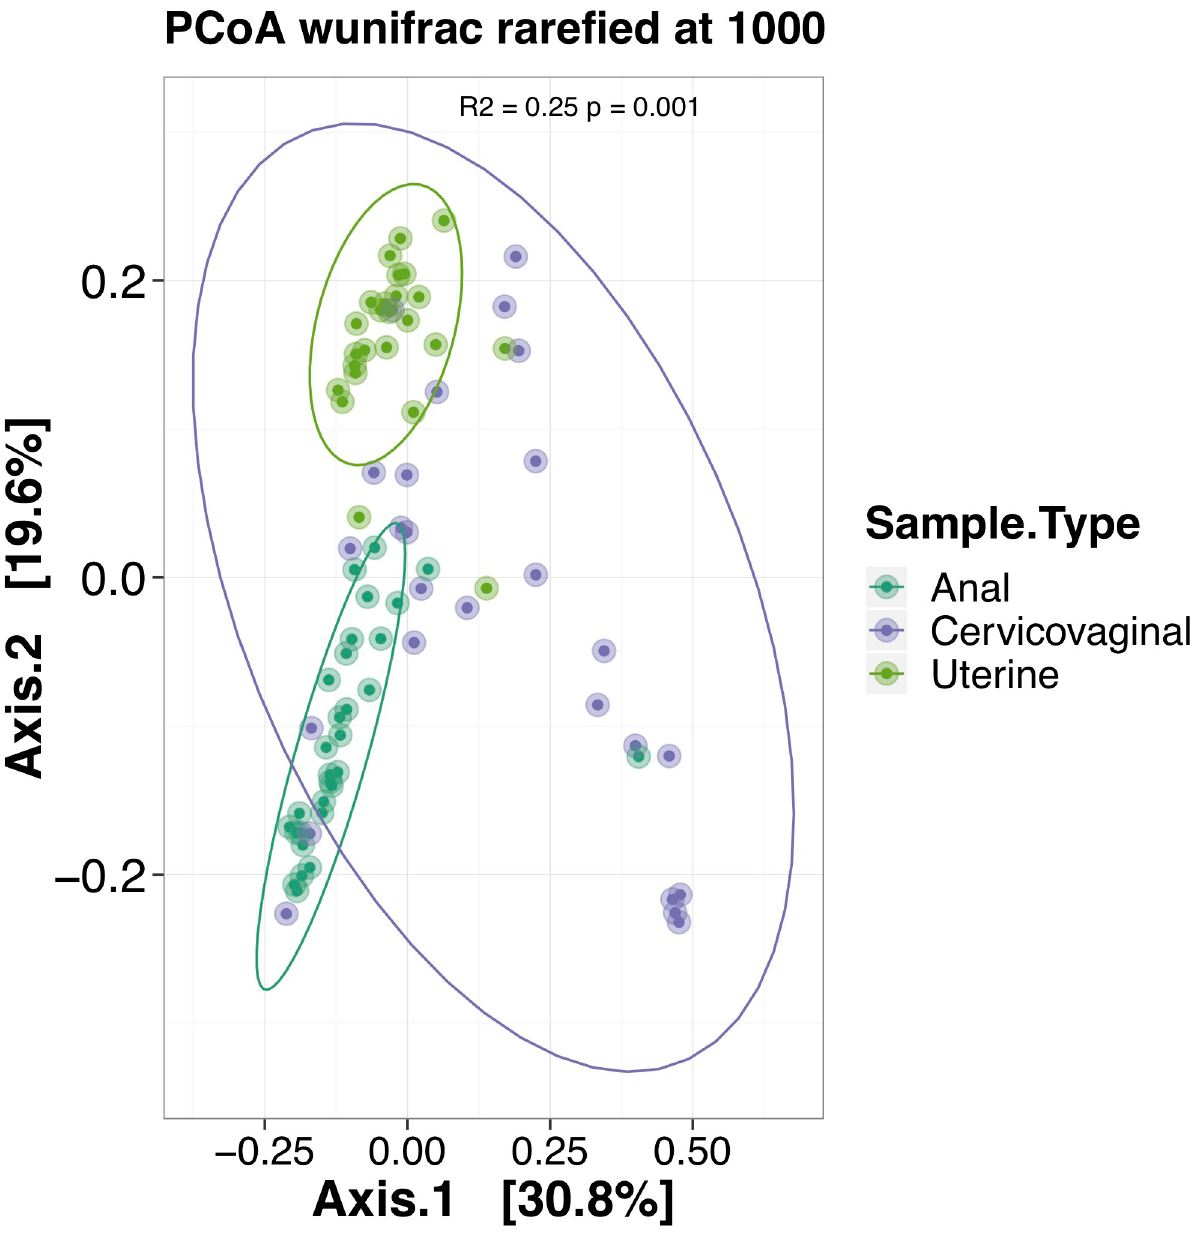
Fig 2. PCoA performed across sampled anatomical sites. The PCoA performed using weighted unifrac distances after subsampling each sample library to 1,000 reads. Ellipses represent 95% confidence intervals for site based sample clustering. PERMANOVA analysis indicates significant community separation at the genus level based on anatomic location (R2 = 0.25, p < 0.001).